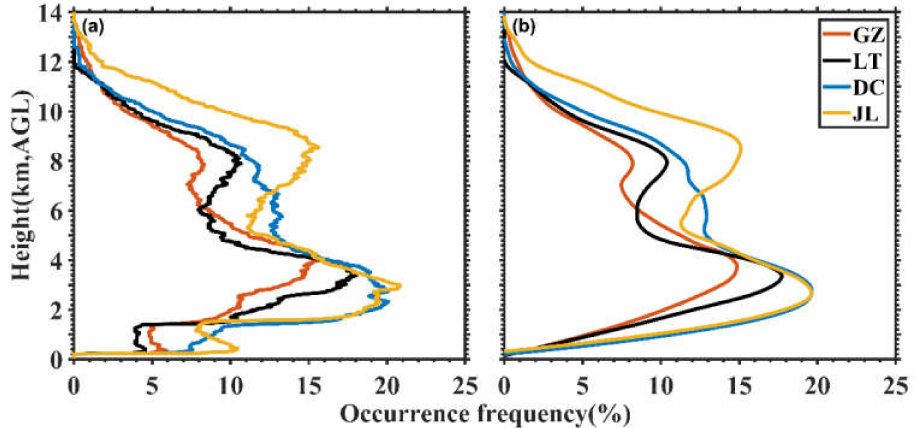
Figure 3. Vertical distributions of cloud occurrences at four sites. Original profiles of cloud oc- currence frequency ( a ), and smoothed profiles of cloud occurrence frequency ( b ), as calculated by Ka-MMCR